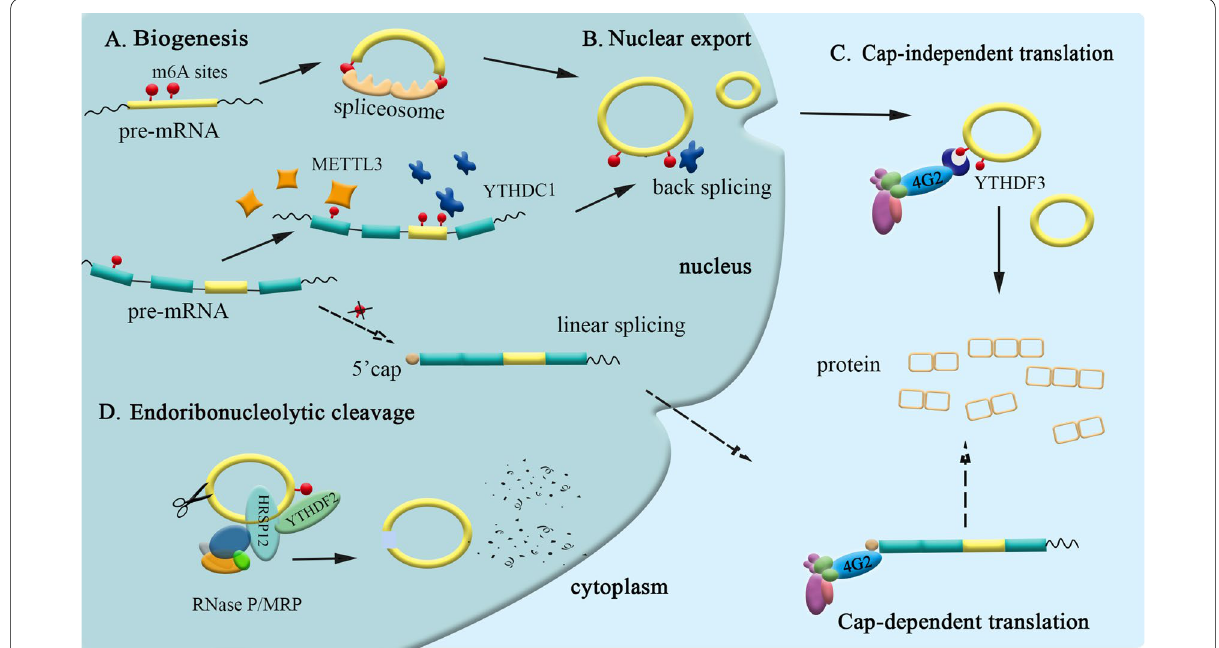
Fig. 3 Roles of m6A modification in circRNAs. A m6A controls biogenesis of circRNAs. Pre-mRNAs with m6A sites recruits spliceosome or enzymes associated with methylation to promote back splicing of pre-mRNAs, while pre-mRNAs without m6A sites go through linear splicing to become linear mRNAs. B YTHDC1 binds to m6A sites in circRNAs to help circRNA nuclear export. C Different from translation initiation complex (IC) that binds to 5 ′ cap to initiate translation of mRNAs, IC binds directly to m6A sites that function as an IRES to initiate translation of circRNAs in a cap-independent way. D CircRNAs can be degraded through endoribonucleolytic cleavage way, where HRSP12 bridges between RNase/MRP and